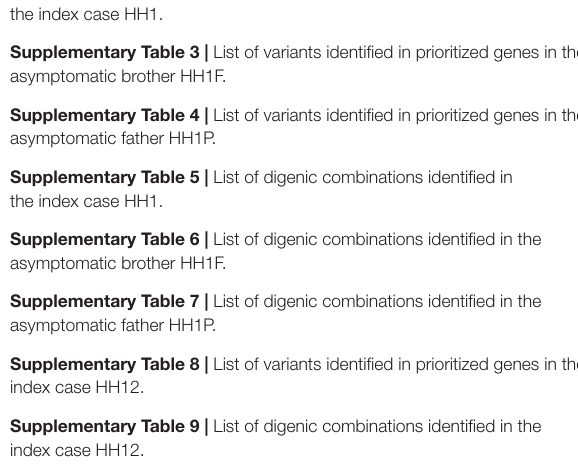
Supplementary Table 9 | List of digenic combinations identified in the index case